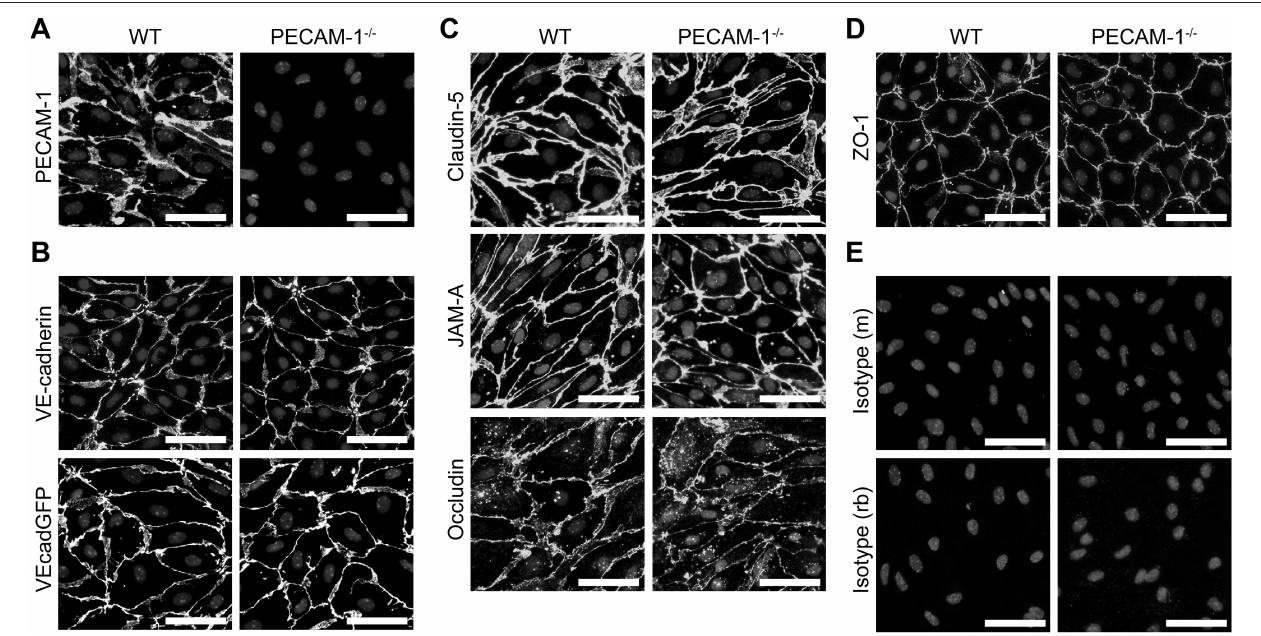
FIGURE 3 | PECAM-1 − / − pMBMECs display an intact junctional architecture. Immunofluorescent stainings of WT and PECAM-1 − / − pMBMEC monolayers were performed for PECAM-1 (A) , VE-cadherin (B) , claudin-5 (C) , JAM-A (C) , occludin (C), and ZO-1 (D) . Additionally, the fluorescent signal of VE-CadGFP-expressing pMBMECs is shown (B) . Also, stainings for mouse and rabbit isotype controls are presented (E) . Cell nuclei were stained with DAPI. Merged grayscale pictures of nucleic signals and the specific antibody stainings are shown. Scale bars, 50 µ